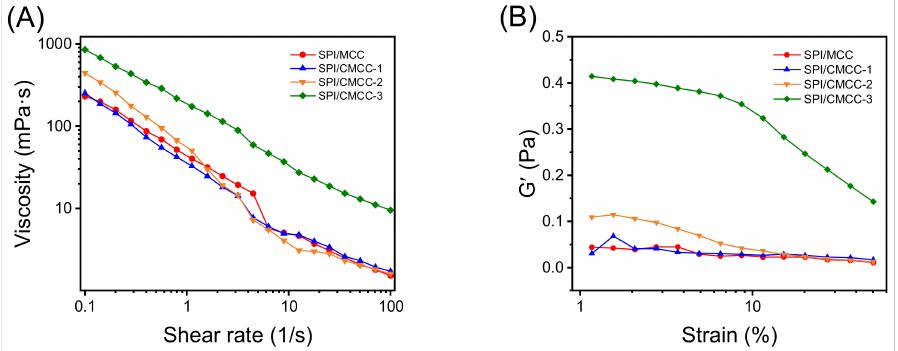
Figure 8. The viscosity ( A ) and the change in storage modulus (G (cid:48) ) ( B ) of complexes for SPI and MCC/CMCC at ratio of 1:3 in a strain sweep